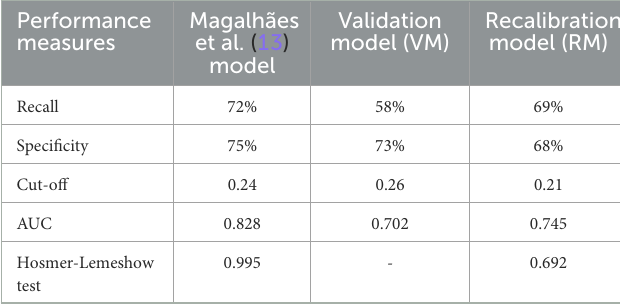
TABLE 7 Comparison of the performance measures obtained in the